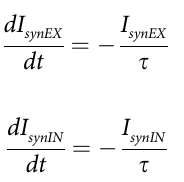
The synaptic effect induced by excitatory and inhibitory synapses was modelled with two dif- ferent exponentially decreasing currents I Eqs (2A) and (2B), respectively: